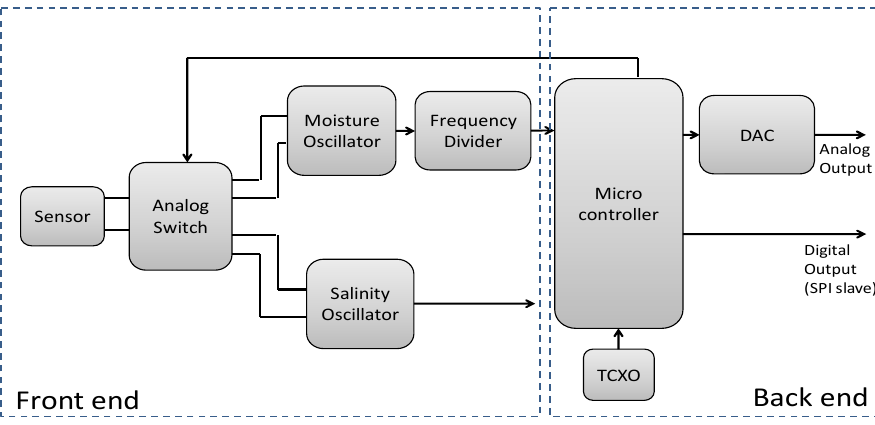
Figure 25. Functional diagram of electronics measurement.